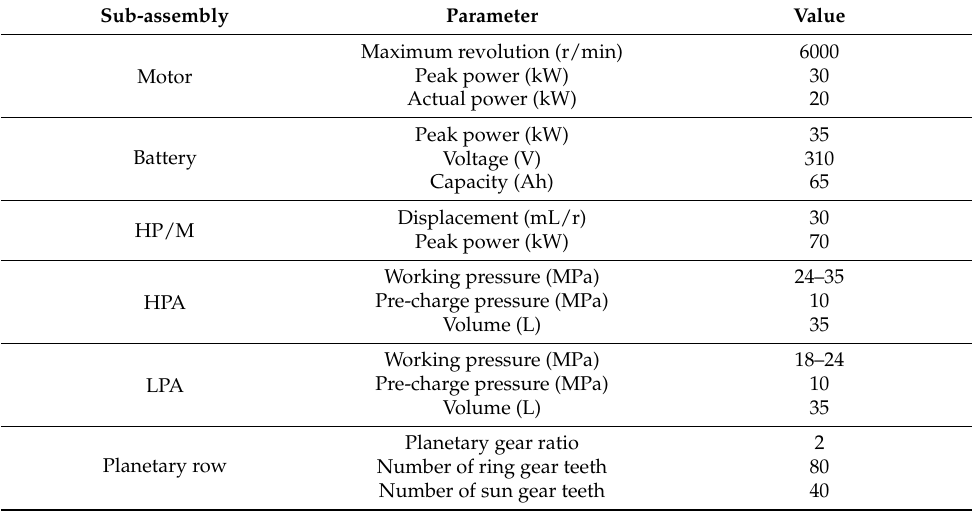
Table 3. Parameters of each element in